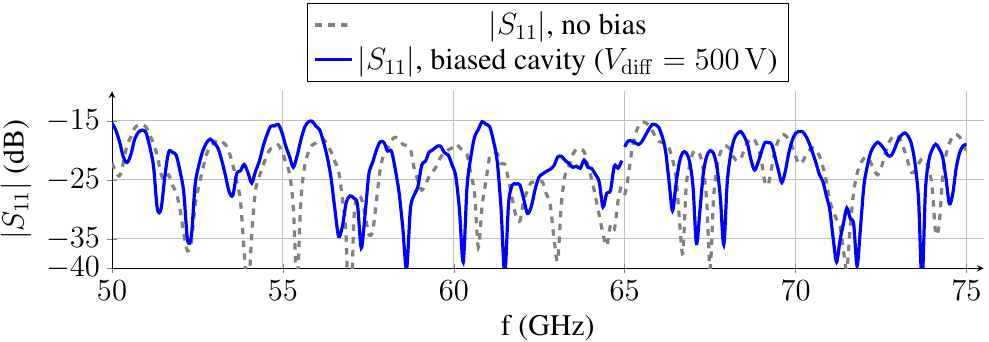
Figure 49. Measured input reflection for an unbiased and fully biased LC